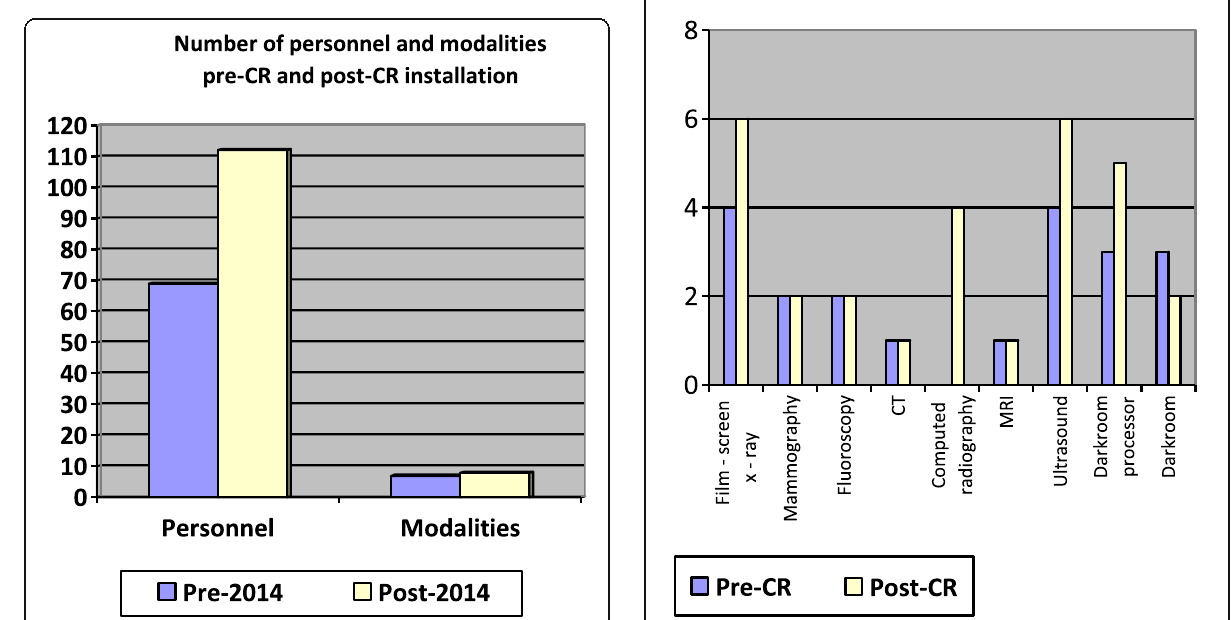
Fig. 3 Frequency of personnel and radiologic modalities in Radiology Department before and after installation of computed radiography